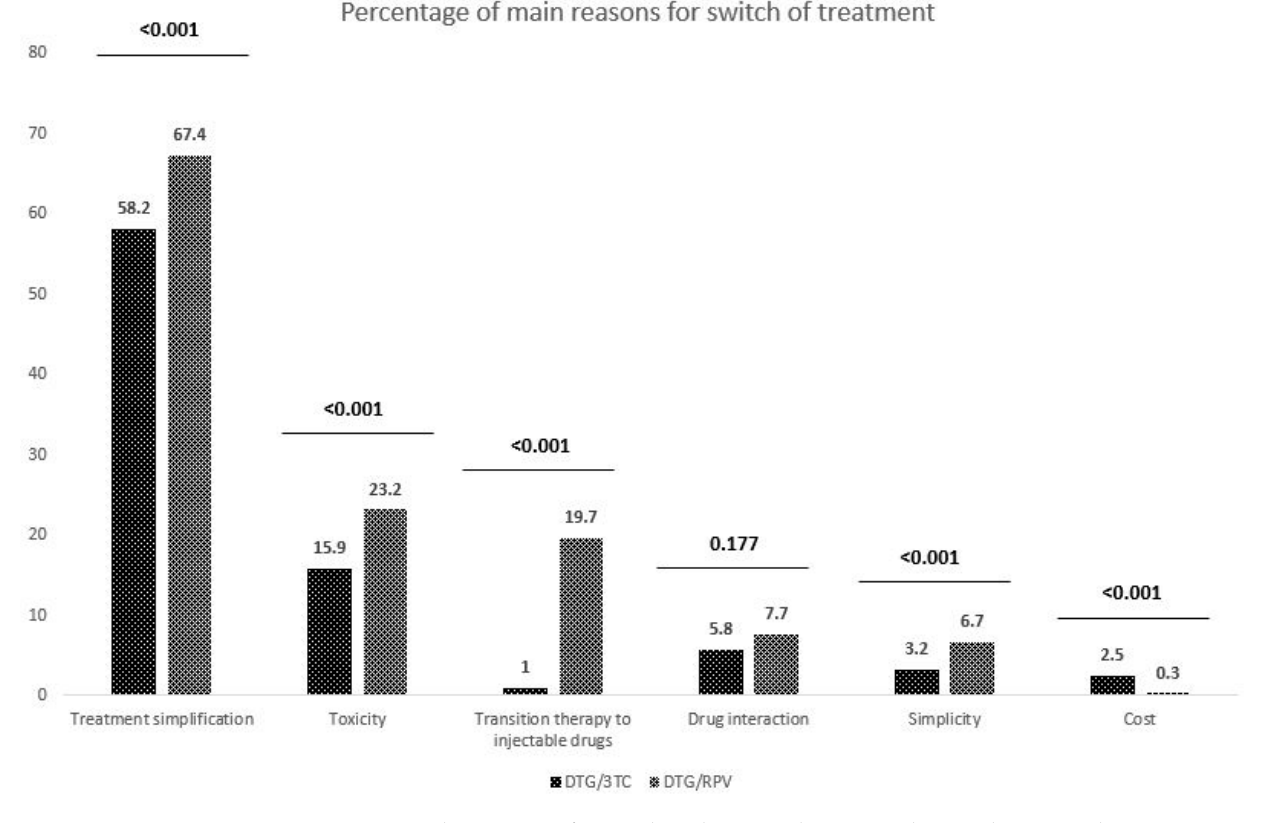
Figure 1. Leading causes of a switch in the DTG plus 3TC and DTG plus RPV cohorts. At baseline, the median CD4+ lymphocyte count was 701.0 [516.0, 933.0] and 759.0 [556.0, 983.8] cells/µL in the DTG plus RPV and DTG plus 3TC groups.